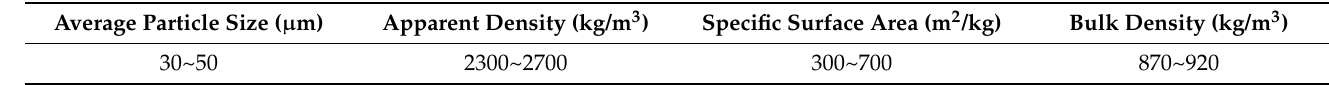
Table 1. Physical index of RP.